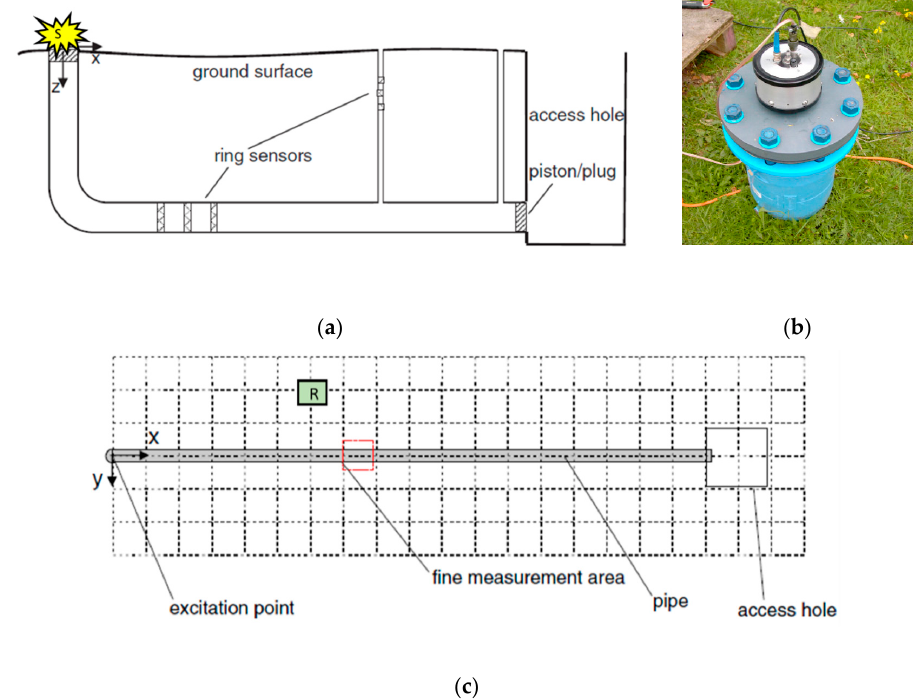
Figure 6. Experimental set-up of pipe excitation method: ( a ) pipe rig layout; ( b ) shaker mounted on plastic end-plate; ( c ) grid of measurement points. [69], Copyright Elsevier, 2011.